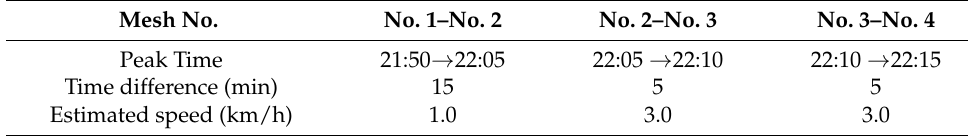
Table 2. Peak time and estimated speed (13 July). Mesh No. No. 1–No.